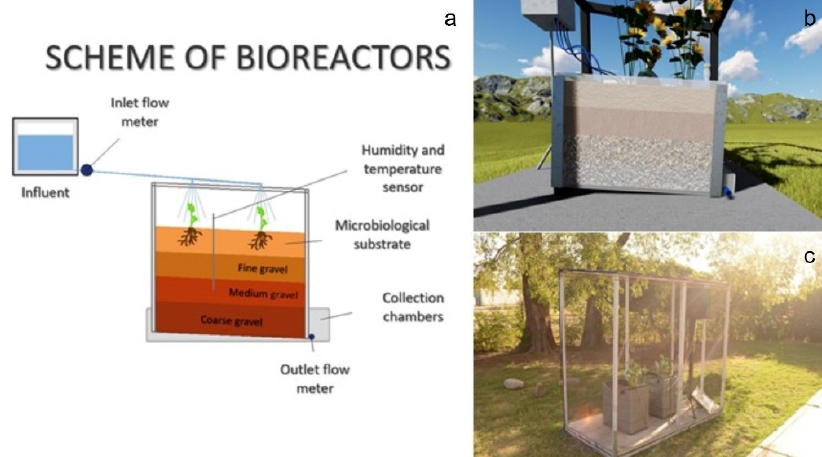
Figure 2. Schemes of the bioreactor (TRL 4). Transversal section of the bioreactor ( a , b ) and general view of the bioreactor at the Bioenvironmental Laboratory ( c ).